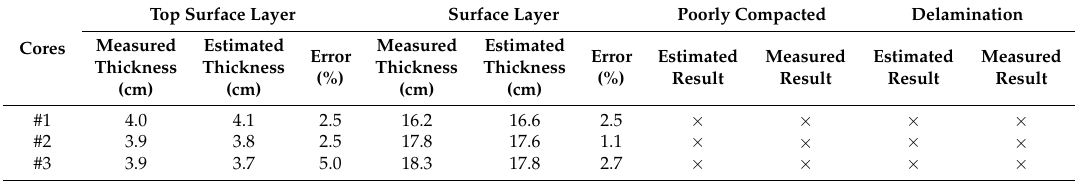
Figure 19. The corresponding GPR signal for ( a ) core#1; ( b ) core#2; ( c ) core#3. The red and blue arrows indicate the reflections from top surface layers and surface layers, respectively. Table 3. The comparison between estimated results from GPR and measured results from field cores.